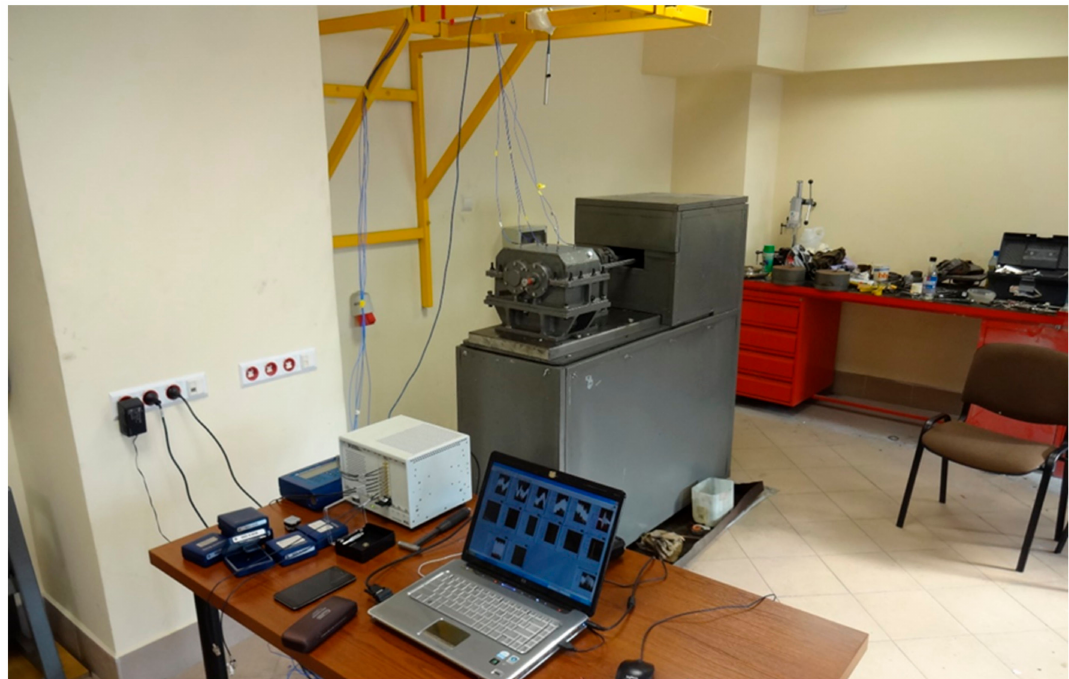
Figure 5. View of the FZG stand and the measuring system for stand tests.